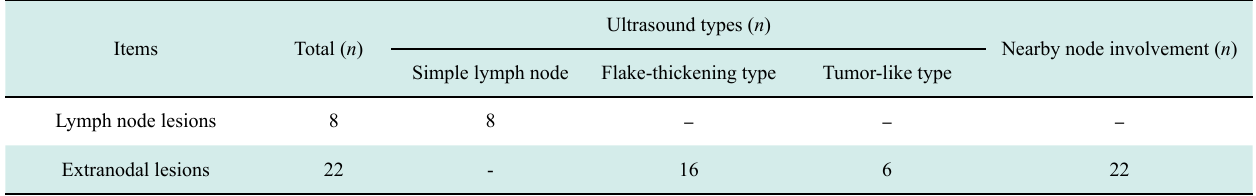
Table 1 Classification of types and location of lesion in Kimura